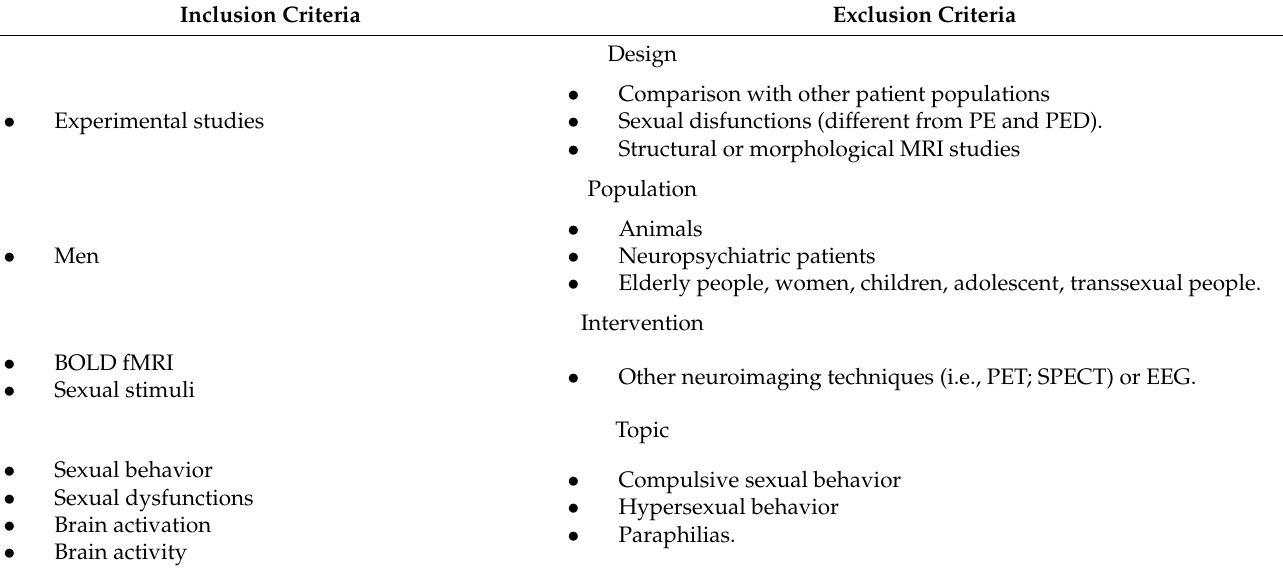
Table 1. Inclusion and exclusion criteria for the selected studies.